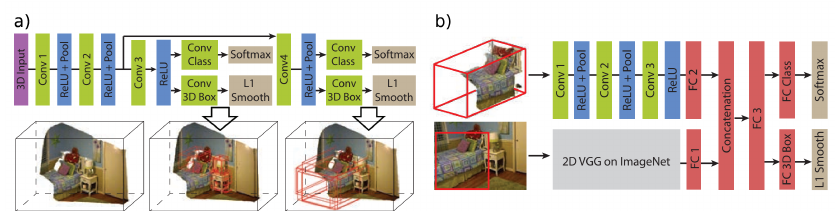
Figure 3. ( a ) 3D amodal region proposal network used for the deep sliding network architecture. Two receptive fields 0.4 m 2 and 1 m 2 for small and large objects, respectively. ( b ) Joint object recognition network. Features are extracted from both 3D voxel grids and 2D spectral images and concatenated together to exploit features from each feature space. Image source: